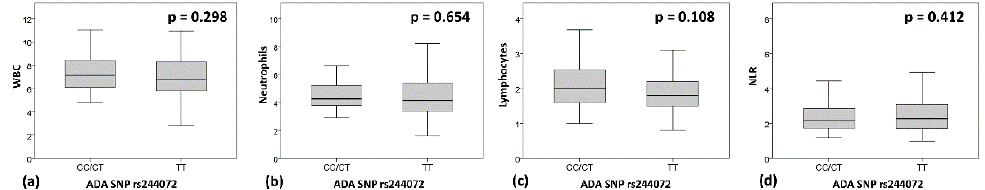
Figure 4. ADA SNP rs244072 and WBC, neutrophils and lymphocytes. Peripheral blood levels of ( a ) WBC, ( b ) neutrophils and ( c ) lymphocytes, and ( d ) NLR, according to SNP rs244072 genotype (CT/CC vs. TT). Mann–Whitney test p values are shown. Abbreviations: neutrophil/lymphocyte ratio (NLR), single nucleotide polymorphism (SNP), white blood cells count (WBC).